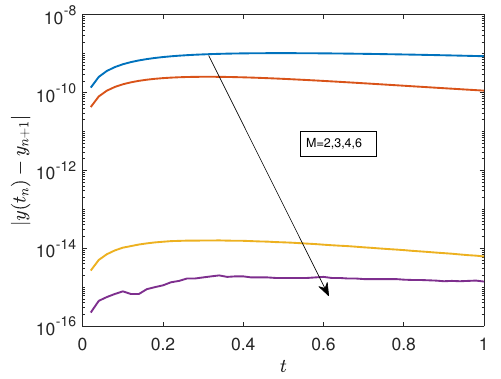
Figure 7. Errors for example